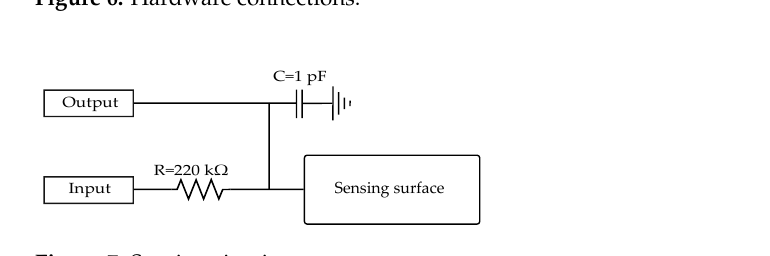
Figure 7. Sensing circuit.